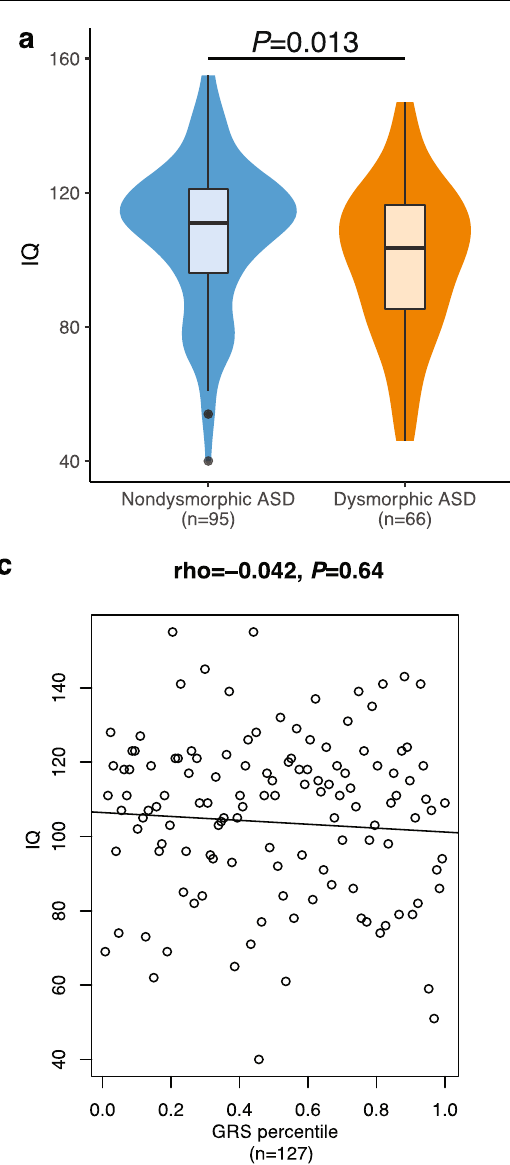
Fig. 5 | Relationship between IQ, morphological ASD subtypes and genetic variants. a Comparison of IQ among morphological ASD subtypes. b Comparison of IQ between probands with and without a CSV. a , b Violin plots show the dis- tributions of the probands ’ IQ; box plots contained within show the median and quartiles of IQ for each subtype, the minima and maxima of box plots indicate 3× the interquartile range-deviated IQ from the median. P values denote the prob- ability that the mean IQ of nondysmorphic ASD or probands without CSVs is not